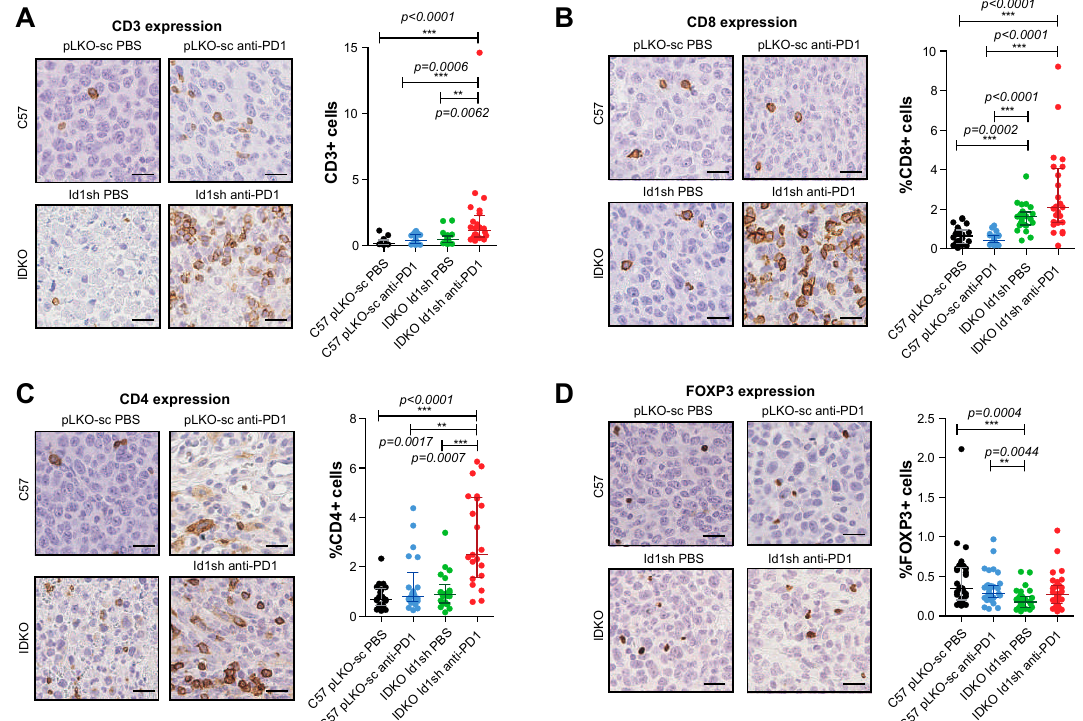
Figure 4. Combined inhibition of Id1 and anti-PD-1 therapy promotes the tumor infiltration of different immune cell populations. ( A ) HC and quantification of CD3 expression in representative sections of tumors belonging to group of mice with extreme phenotypes [ Id1+/+ /DPBS (pLKO-sc LLC cells), Id1+/+ /anti-PD-1 (pLKO-sc LLC cells), Id1-/-/ DPBS (Id1sh LLC cells) and Id1-/-/ anti-PD-1 (Id1sh LLC cells]. ( B ) IHC and quantification of CD8 expression in representative sections of the same tumors as in A. ( C ) IHC and quantification of CD4 expression in representative sections of the same tumors as in A. ( D ) IHC and quantification of FOXP3 expression in representative sections of the same tumors as in A. The data are reported as the median with the interquartile range or mean ± SD. ** p < 0.01, *** p < 0.001, n.s. (not significant). Scale bar, 30 µm.